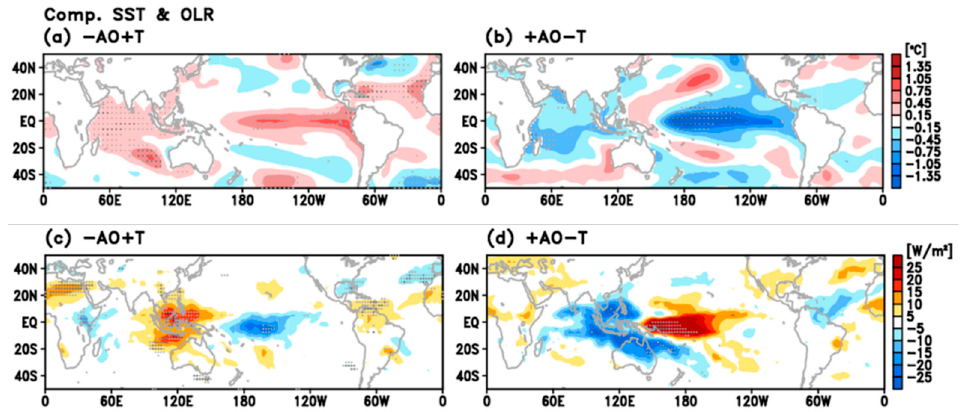
Figure 5. Composite maps of sea surface temperature (SST) anomalies in winter season for in ( a ) − AO + T and ( b ) +AO − T group. ( c ) and ( d ) are same as ( a ) and ( b ) but for outgoing longwave radiation (OLR) anomalies. Light (dark) gray dots denote grid points which satisfy 90% (95%) confidence level through the two-tailed Student’s T-test.